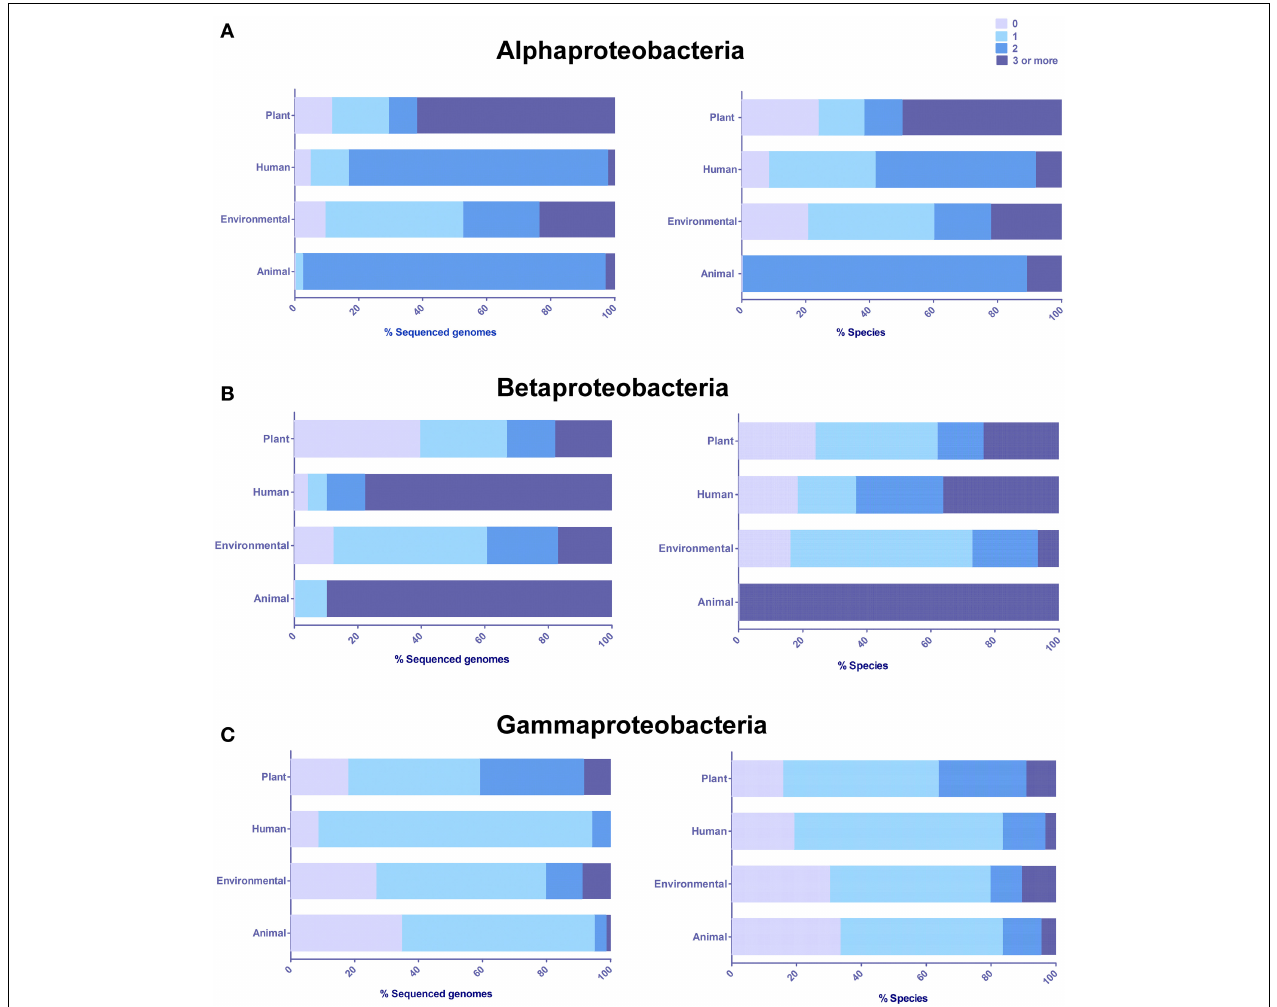
FIGURE 2 | Distribution and abundance of LuxR solos in different classes based on the origin or predominant niche specificity of bacterial species harboring these proteins. (A) Alphaproteobacteria (B) Betaproteobacteria, (C) Gammaproteobacteria. Plant, Plant-associated bacteria; Human, Human-associated bacteria; Environmental, Environmental isolates; and